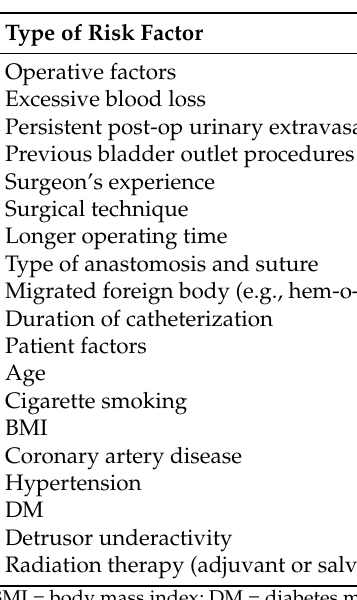
Table 1. Potential risk factors of postoperative posterior urethral